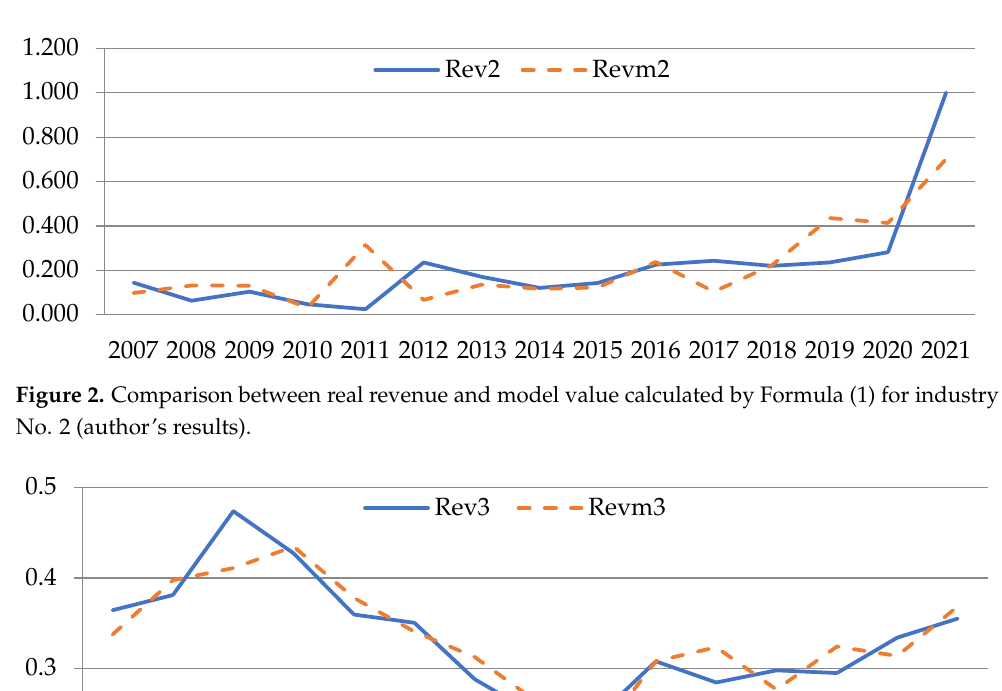
Figure 1. Comparison between real revenue and model value calculated by Formula (1) for industry No. 1 (author’s results).